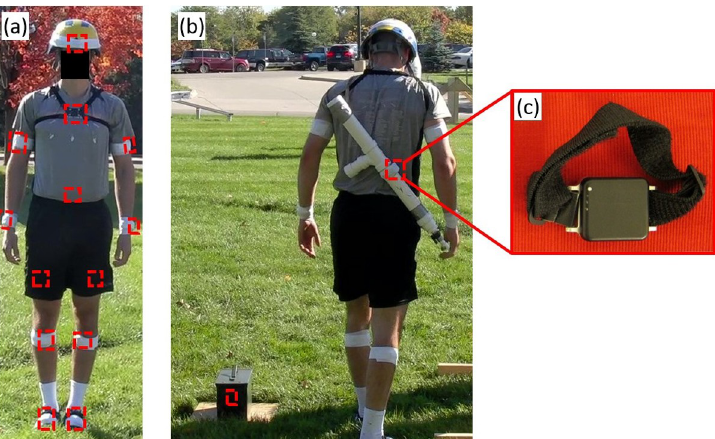
Fig 1. Participant outfitted with equipment (unloaded condition). (a) Participant wearing an array of IMUs (red rectangles) attached to major body segments and in the approximate locations shown (sacrum IMU on posterior). (b) Participant with the mock rifle slung over the shoulder with additional IMU nodes attached to the mock rifle and embedded in the ammo can. (c) Image of single IMU node with integrated Velcro